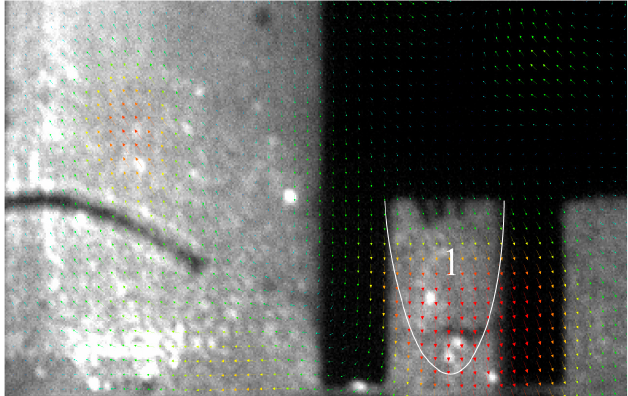
Figure 8. Vector diagram of soil displacement for MP − 8 model.